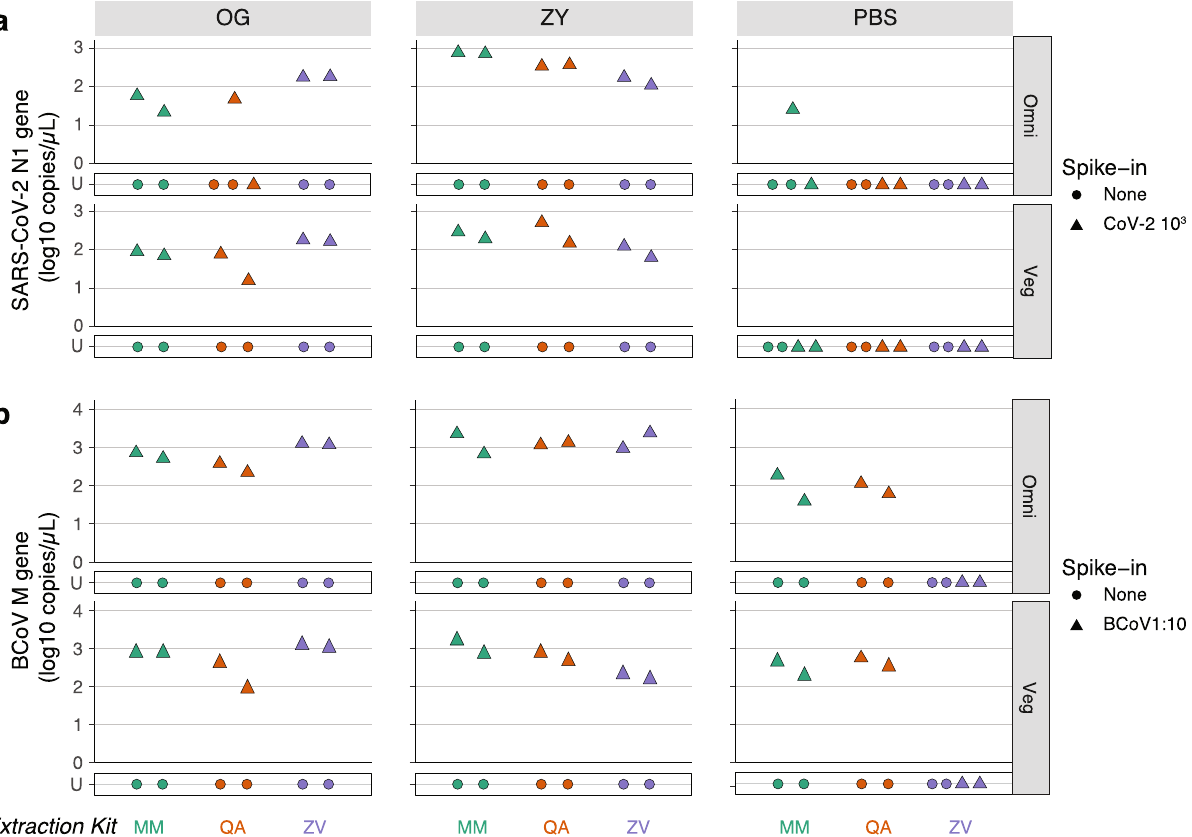
Fig. 3 Evaluating preservation and extraction of SARS-CoV-2 and BCoV RNA from non-standardized stool samples using ddPCR. Stool samples were collected from healthy omnivorous (Omni) and vegetarian (Veg) donors and spiked with ATCC CoV-2 RNA or BCoV vaccine. Spiked stool was preserved in the OMNIgene-GUT Kit (OG), Zymo DNA/RNA shield buffer (ZY), and PBS (as indicated in the tab on the top). RNA was extracted from these samples by two independent users using the MagMAX Viral/Pathogen Kit (MM; green), QIAamp Viral RNA Mini Kit (QA; orange), or Zymo Quick-RNA Viral Kit (ZY; purple) as indicated on the x -axis. RNA was assayed using ddPCR. a Absolute concentration of SARS-CoV-2 RNA assayed by ddPCR targeting the N1 gene is plotted on the y -axis. Healthy stool samples were spiked with 10 3 (triangle) copies of ATCC synthetic SARS-CoV-2 RNA. b Absolute concentration of BCoV RNA assayed by ddPCR targeting the M gene is plotted on the y -axis. Healthy stool samples were spiked with 1:10 diluted (triangle) BCoV vaccine. Control samples with no spiked in RNA (none; circle) were included in duplicate to estimate LoB. U stands for undetermined and marks samples with no detectable RNA above LoB. Two-sided paired T tests were performed on n = 4 independent extractions for each target. Associated statistics are summarized in Supplementary Data 3. Source data are provided as a Source data fi